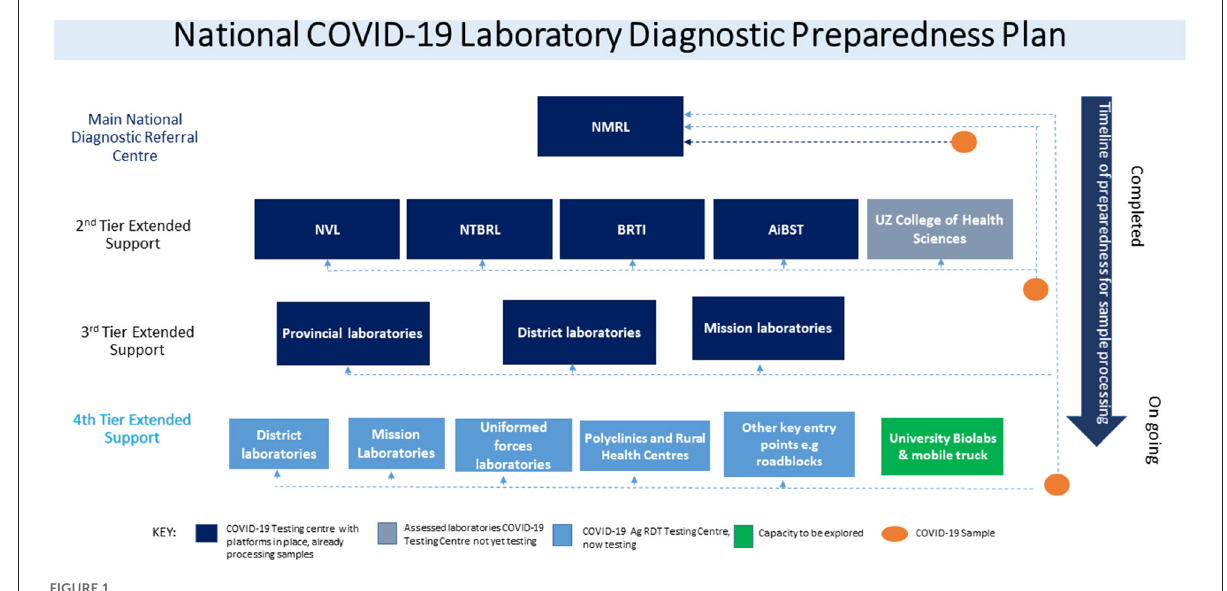
FIGURE1 National COVID-19 Laboratory preparedness strategy plan: Tier